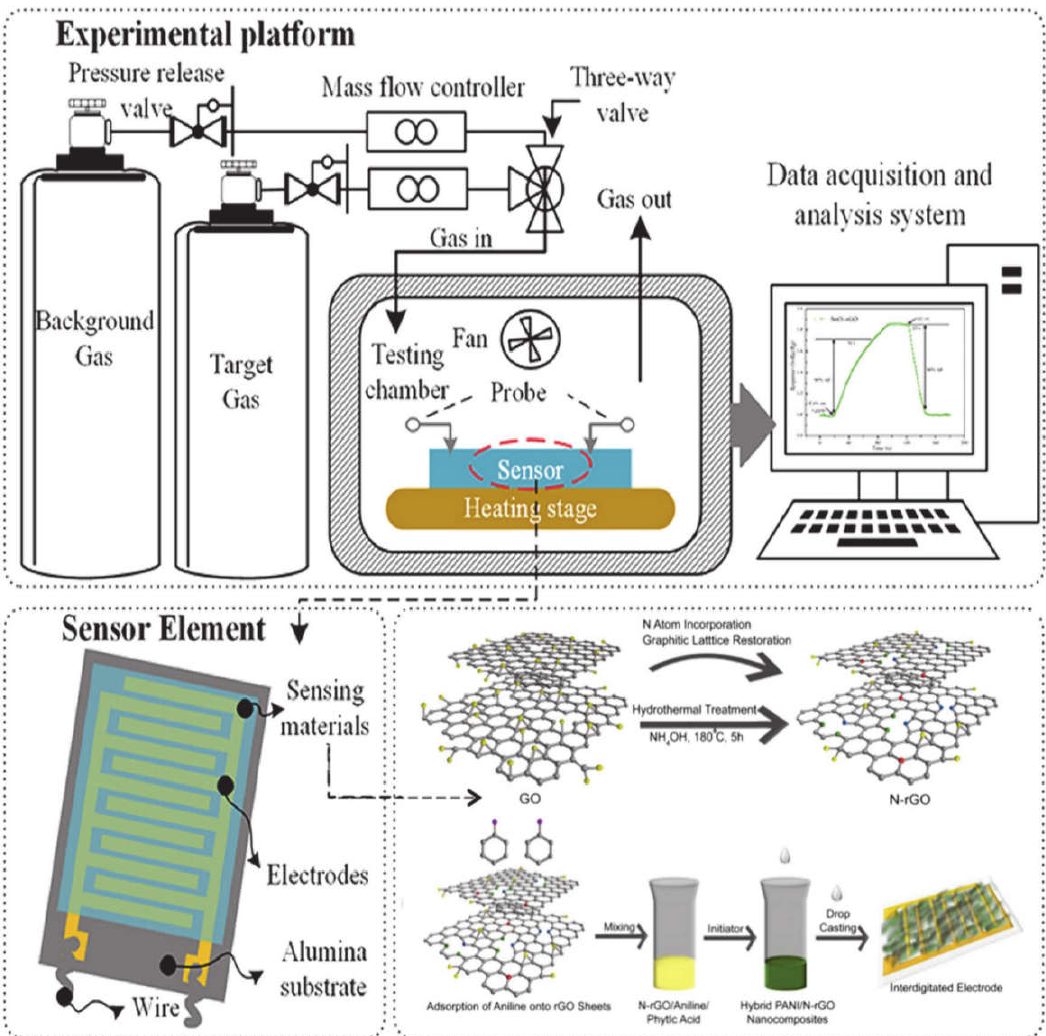
Figure 10. Schematic illustration of a chemiresistive gas sensor showing the electrodes and sensor devices. Adapted with permission from [82]. Copyright MDPI 2020. devices. Adapted with permission from [82]. Copyright MDPI